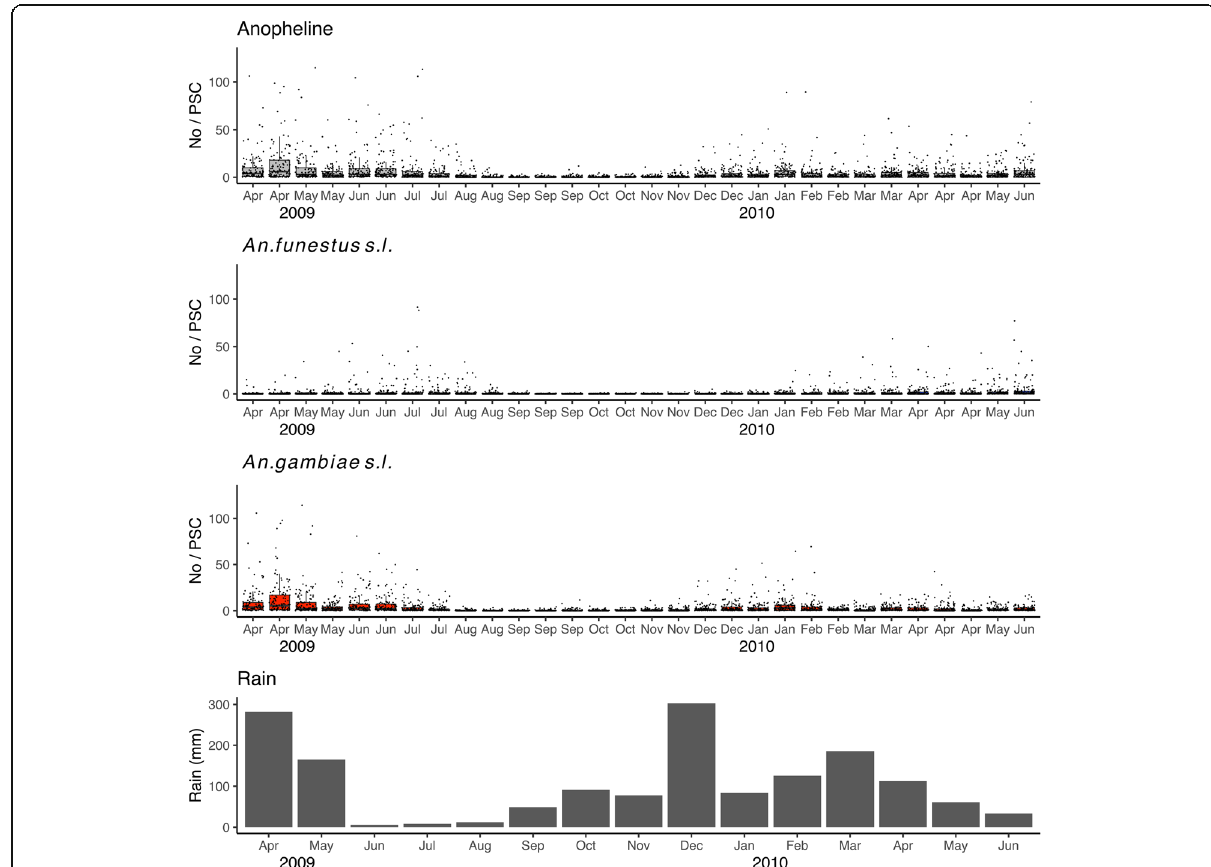
Fig. 2 Temporal changes in the numbers of anopheline mosquitoes and monthly rainfall. Anopheles funestus s. l. and An. gambiae s. l. were collected biweekly from 10 sentinel houses within each cluster using the pyrethrum spray catch method during the period from April 2009 to April 2010. The rainfall data were obtained from an automated weather station (AWS) in the ICIPE Thomas Odhiambo Campus, Mbita, Homabay County, Kenya. The closest distance from the study area to the AWS was approximately 11